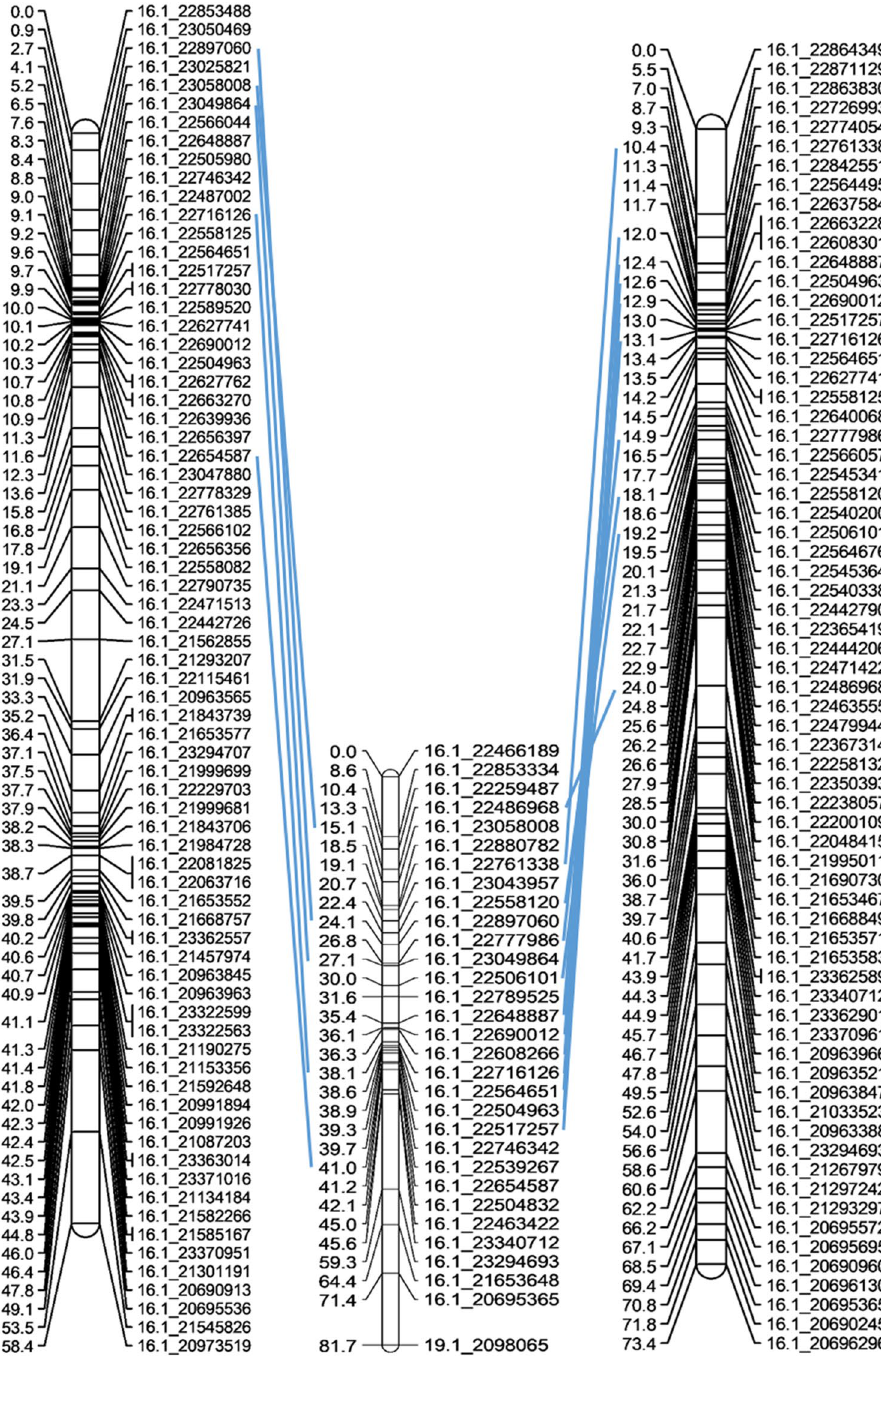
Figure 2. New parental maps of chromosome LG16 for the male Kabusa (on the left) and female 74F (on the right). The consensus map is in the middle. In blue are showed the common